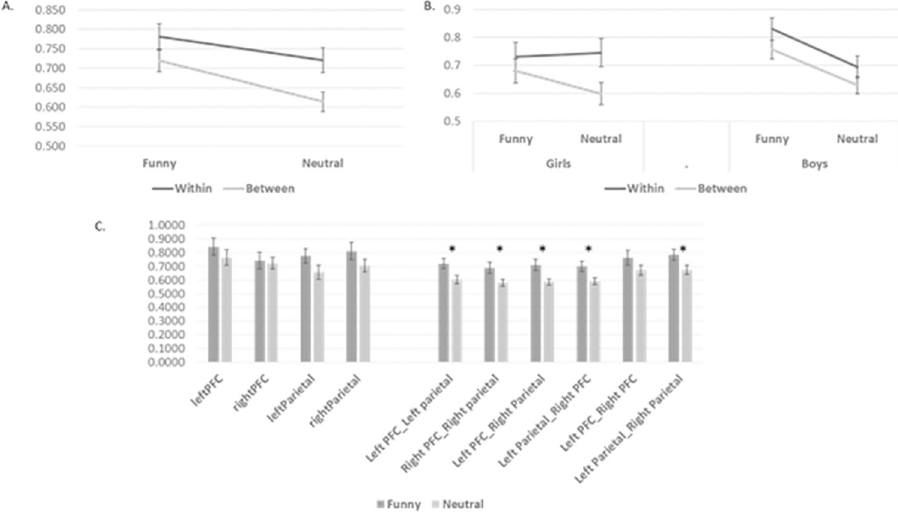
Fig 4. (A) Coherence analysis between and within regions (B) Coherence analysis between and within regions separated for girls and boys (C) Paired t-test analysis between funny and neutral conditions. � significant result at p < 0.05 FDR